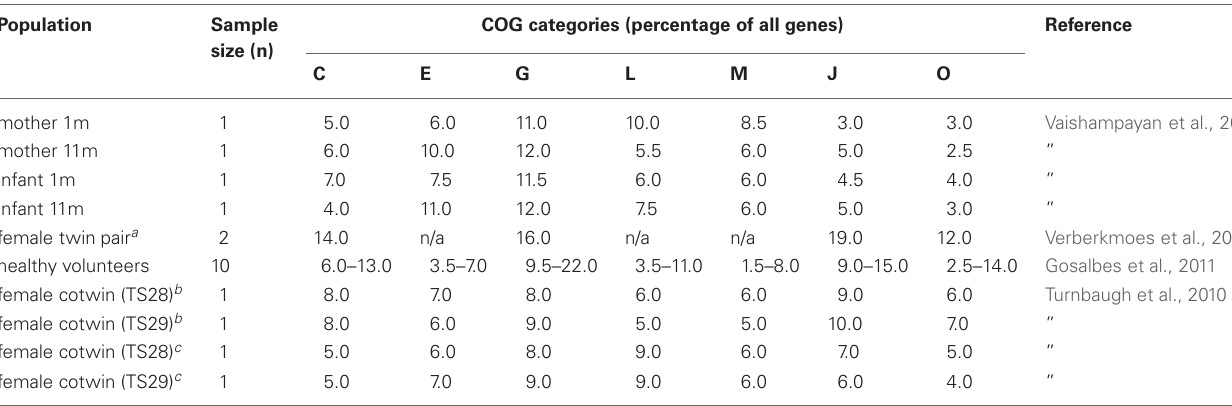
Table 1 | Percentages of COG categories expressed in the gut microbiota.